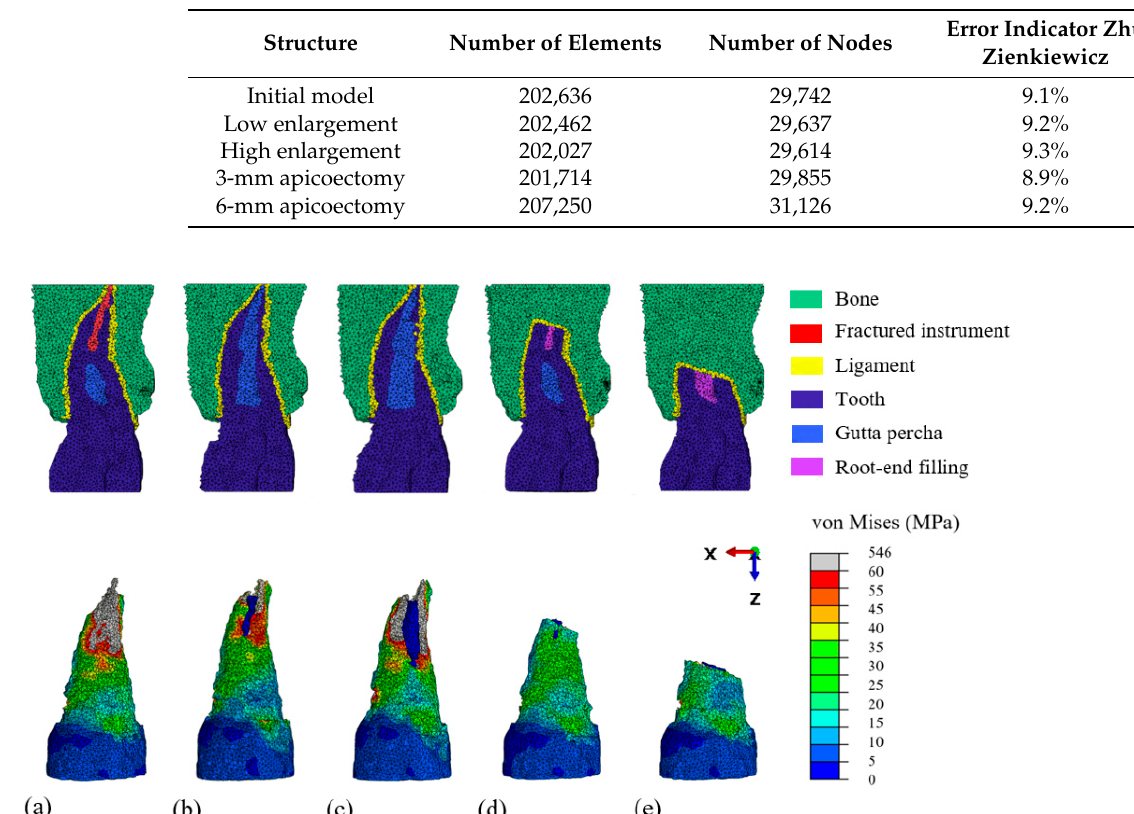
Table 2. Number of elements, nodes, and error indicator according to the finite element model considered.